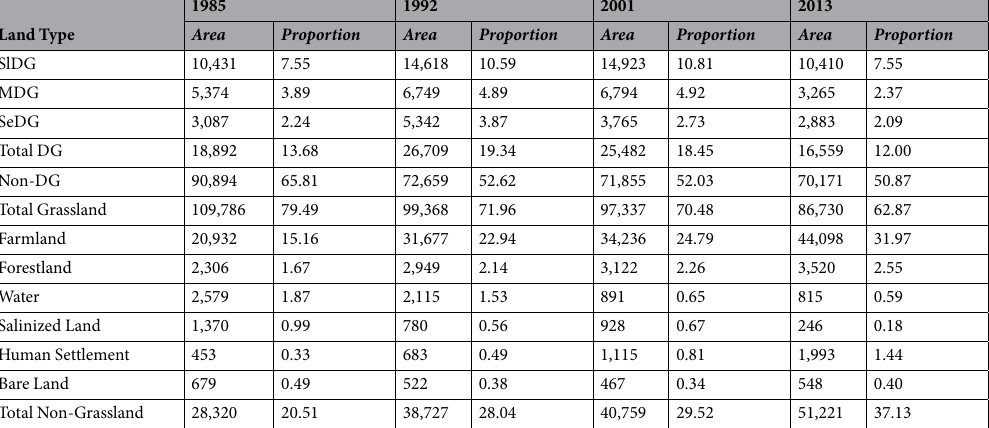
Table 1. Areas and proportions of each class over four periods in the Horqin Sandy Land (Area: km 2 , Proportion: % of Horqin Sandy Land). SlDG: Slightly desertified grassland, MDG: Moderately desertified grassland, SeDG: Severely desertified grassland, DG: Desertified